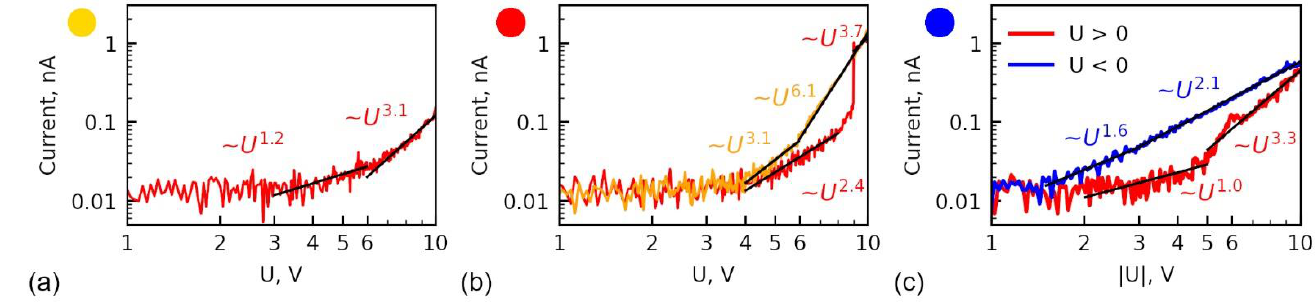
Figure 8. Analysis of ( a ) non-hysteretic I-V dependencies from Figure 3a, ( b ) hysteresis I-V dependencies with RS from Figure 3e, ( c ) symmetric I-V dependencies from Figure 3i. The red and orange colors in ( b ) respect to the voltage rise and fall. The color circle indicates the type of the curve according to maps in Figure 3m – p.